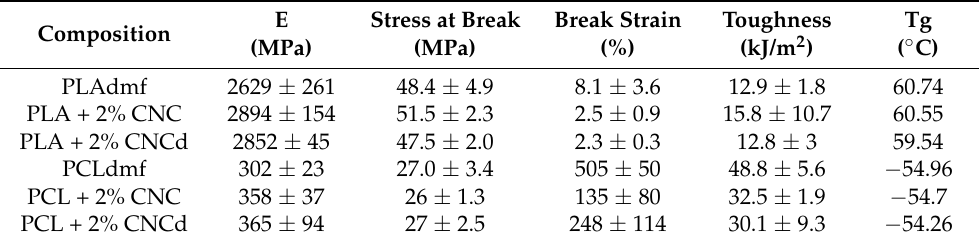
Table 2. Effect of CNC and CNCd on properties of